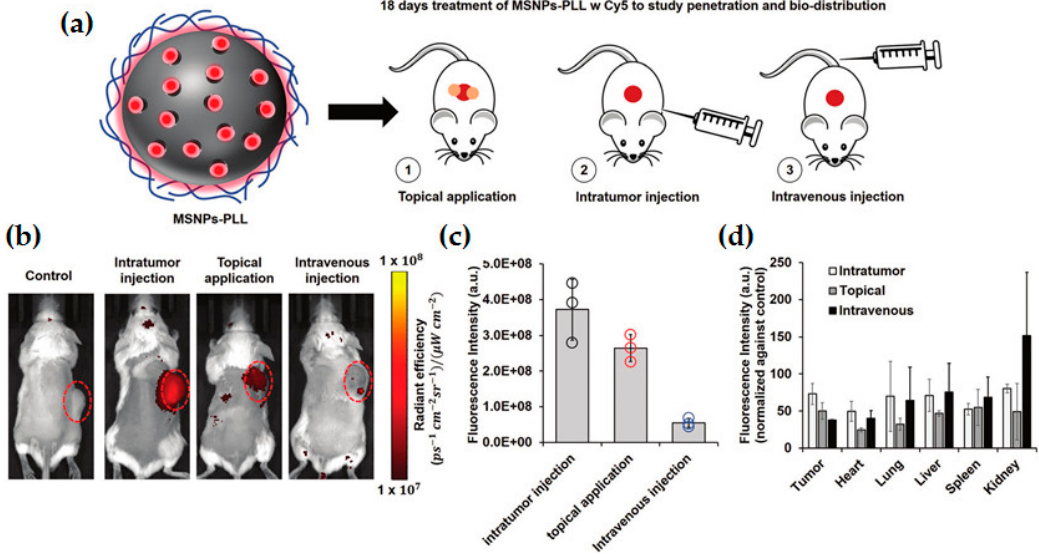
Figure 13. Biodistribution studies of Cy5-marked PLL-coated MSNs: ( a ) Illustration of the administration routes tested for in vivo studies in squamous cell carcinoma (SCC) mice xenograft model; ( b ) Representative IVIS images of mice treated with Cy5-marked PLL-MSNs; ( c ) Fluorescence quantification of IVIS images; ( d ) Intensity of fluorescence of isolated tumor and major organs after 18-day treatment. Adapted from [78], with permission from Royal Society of Chemistry.